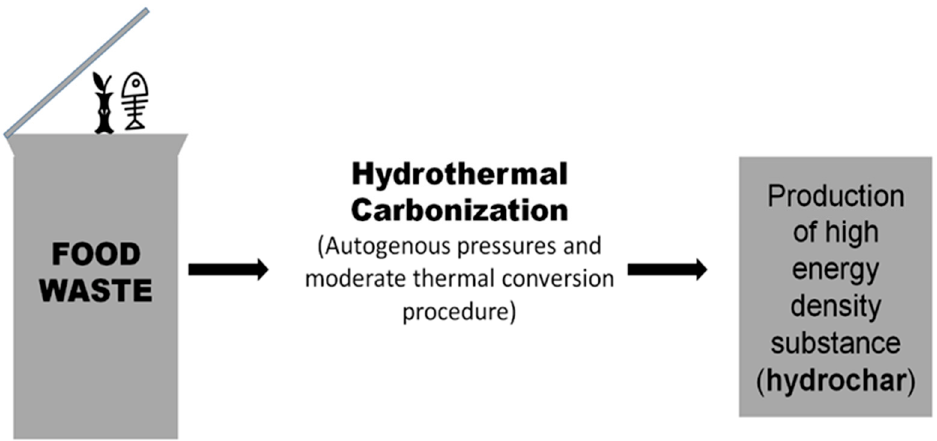
Figure 2. Waste to energy conversion by hydrothermal carbonization.